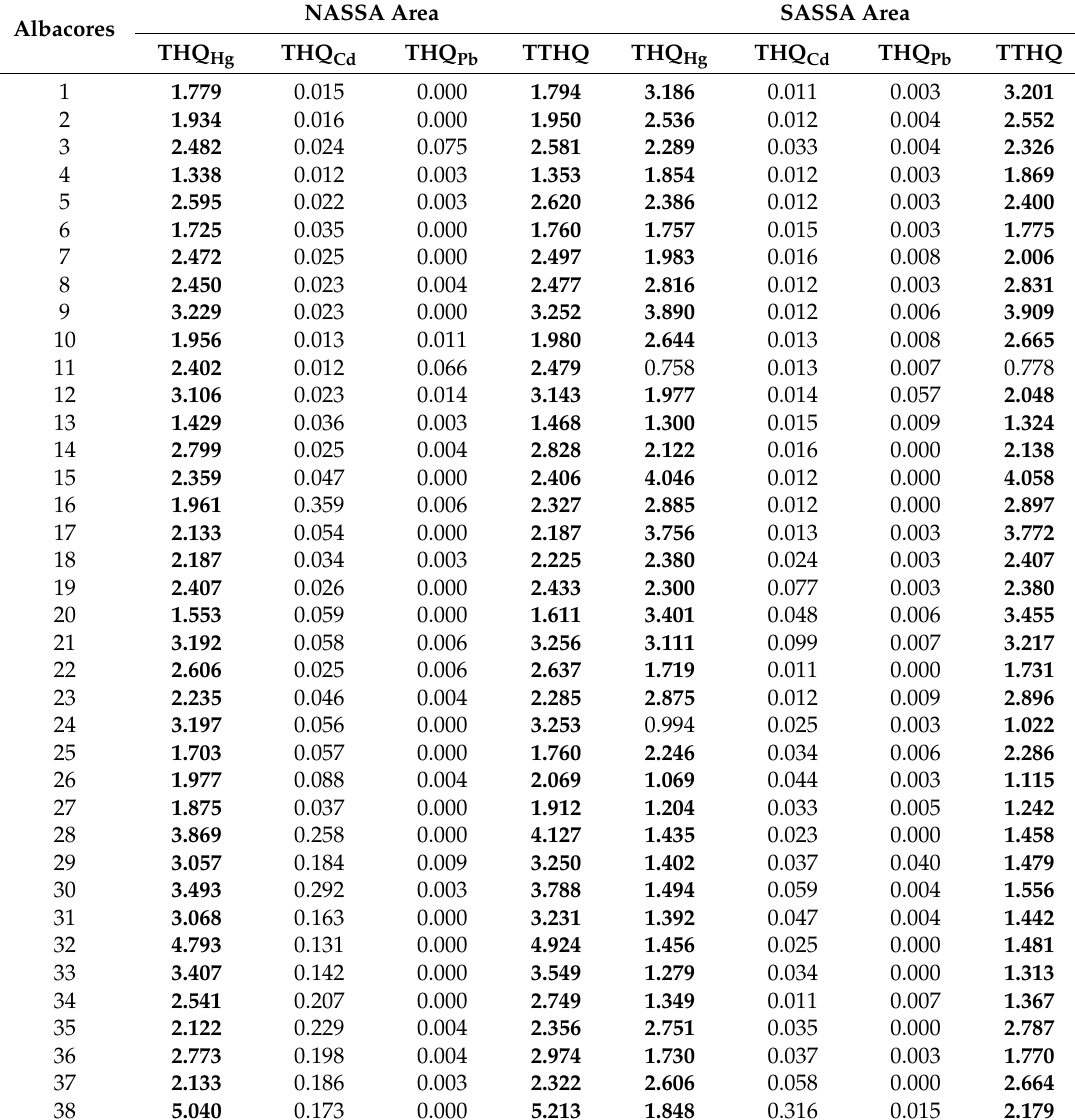
Table 1. Values of target hazard quotient (THQ) and total target hazard quotient (TTHQ) per individual albacore ( T. alalunga ), caught from NASSA and SASSA areas, Greece